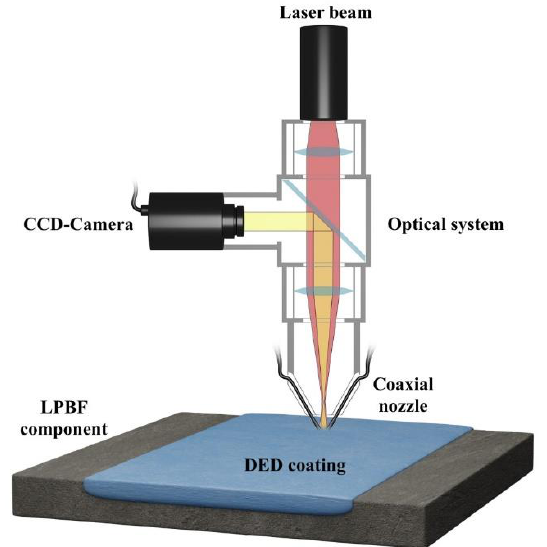
Figure 1. Schematic overview of the directed energy deposition system and monitoring setup used for coating.